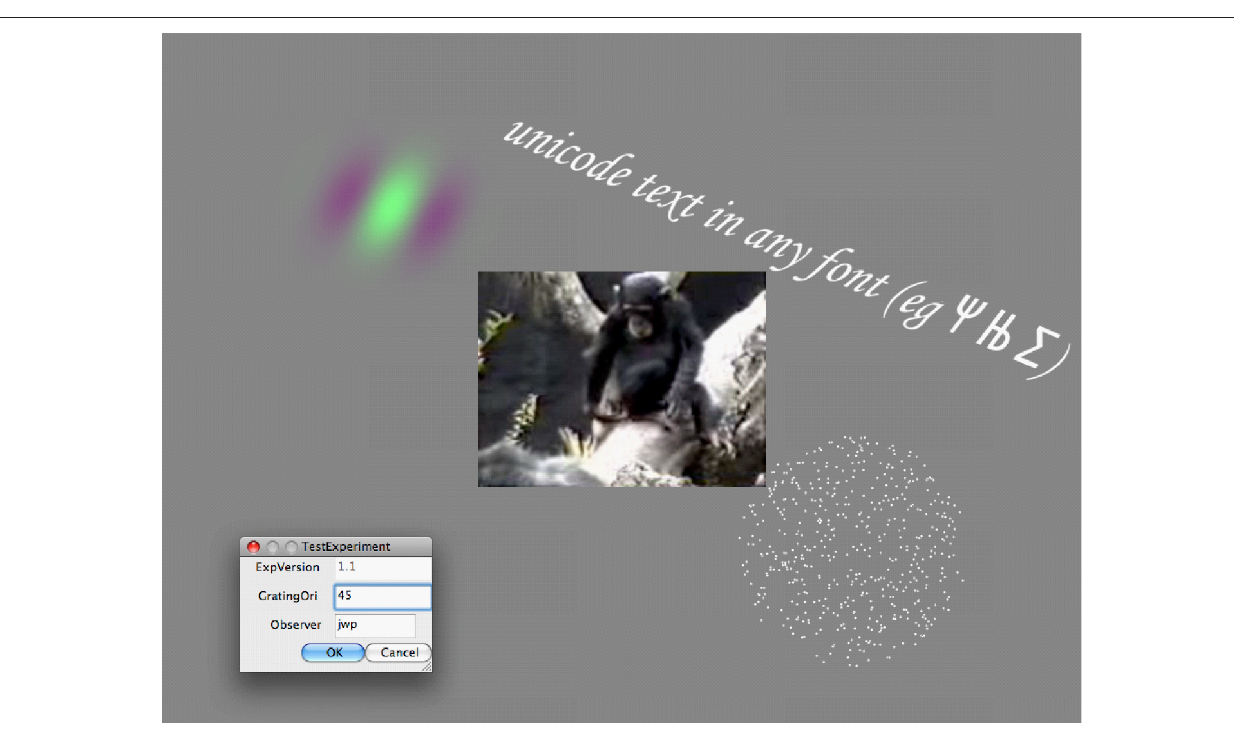
FIGURE 3 | A sample of PsychoPy components. Within the Window is a coloured Gabor from PatchStim , some rotated Unicode text from the TextStim and 500-dot DotStim . The central image is actually a MovieStim .